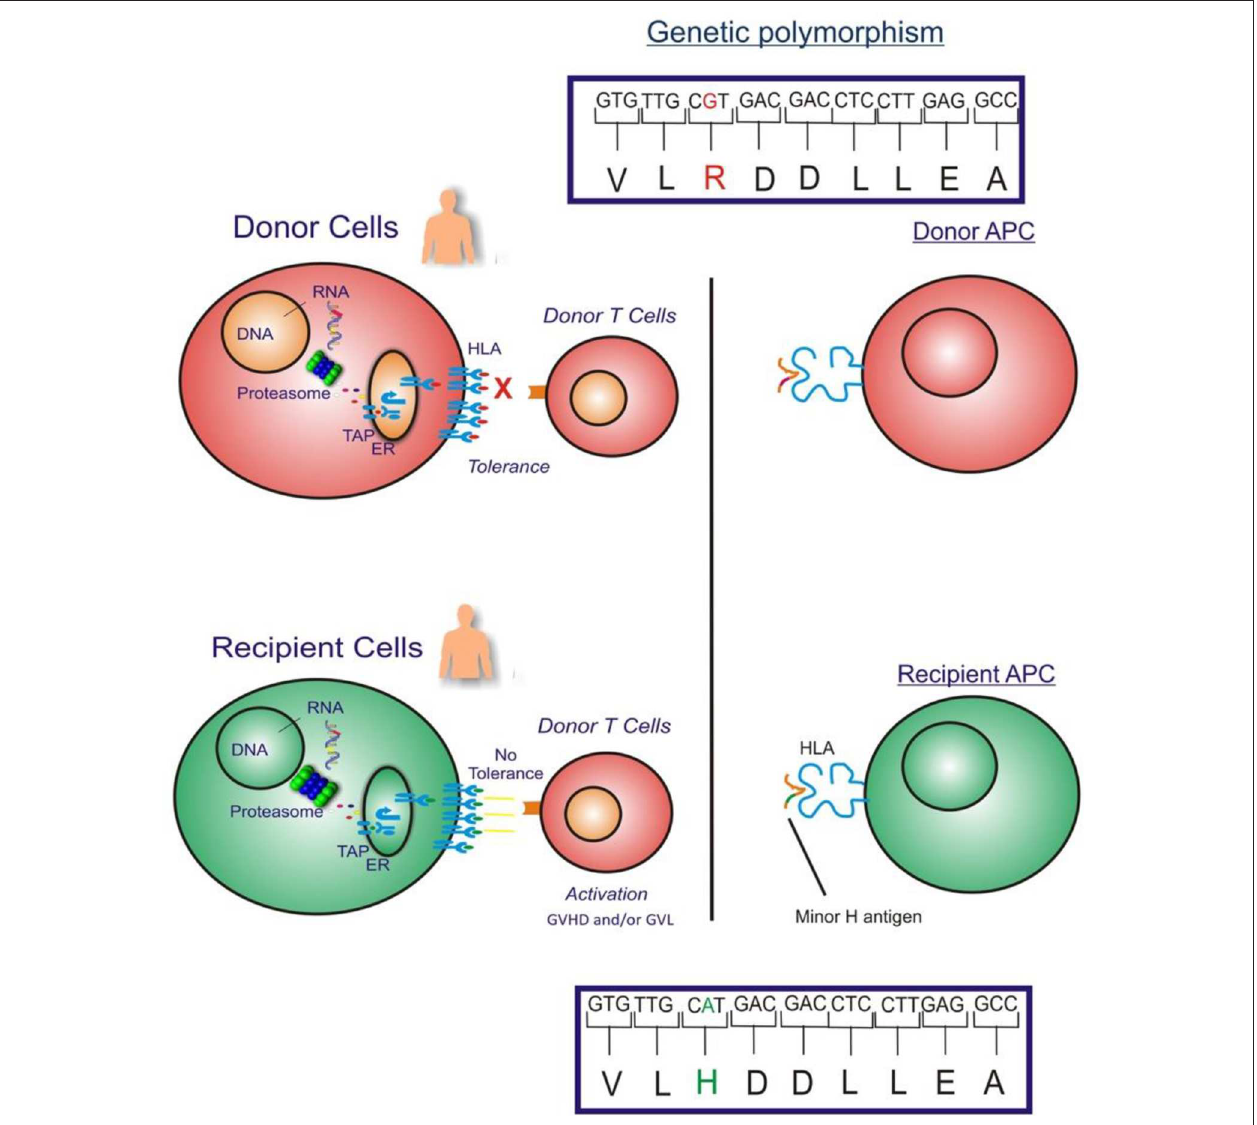
FIGURE 1 | The figure illustrates the GVHD and/or GVL effect in allogeneic HLA-matched donor HCT which is largely attributed to donor T cell responses to recipient cell minor H antigens. When an HCT recipient has a homozygous or heterozygous polymorphism that encodes a minor H antigen and their donor is homozygous negative for the allele, the donor may have T cells in their repertoire that can target the minor H antigen peptide/HLA complex on the recipient’s leukemia cell surface leading to an elimination of any residual leukemia following